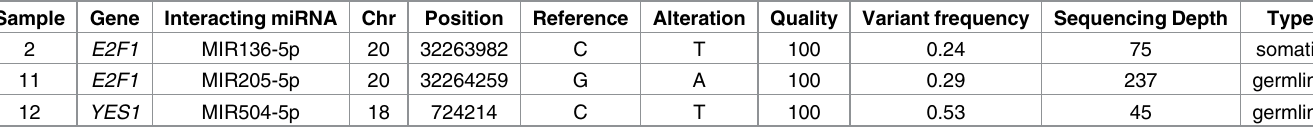
Table 3. Position and sequencing characteristics of mutations found in miRNA predicted target sites.